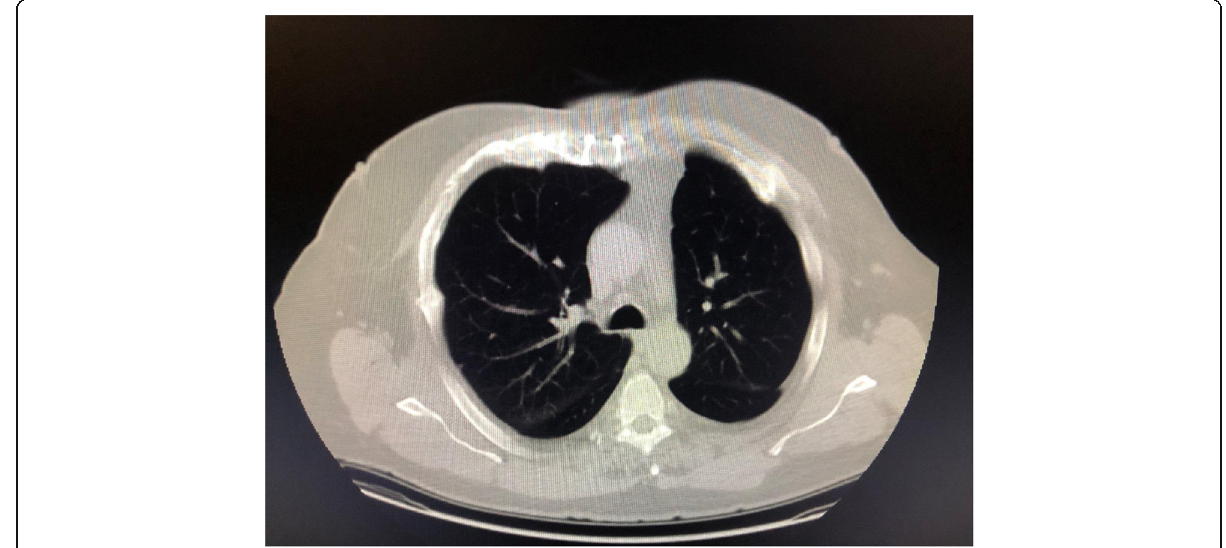
Fig. 5 Follow-up tomography 9 months postop, showing resolution of the flail chest and hardware in